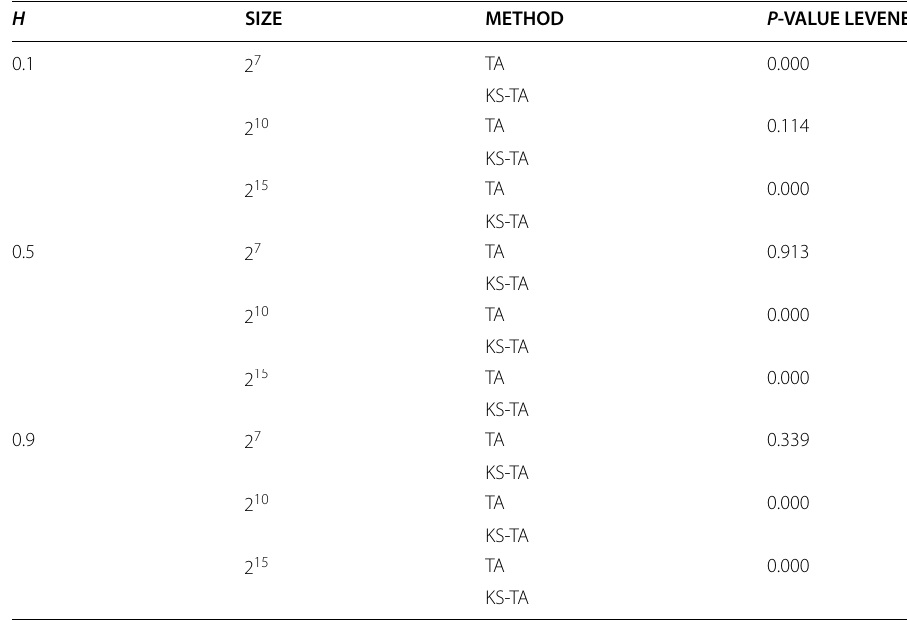
A p ‑value less than 0.01 means that the standard deviations of the two algorithms are significantly